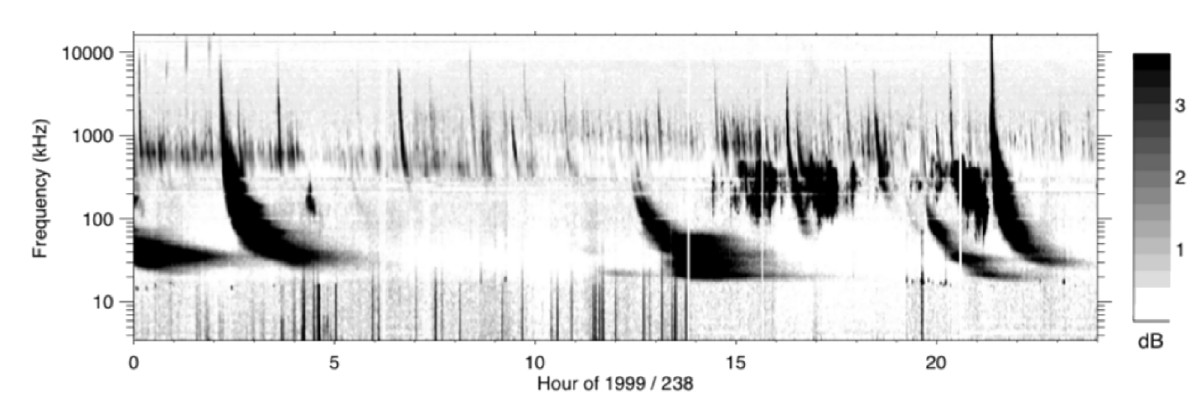
FIGURE 1 Low frequency radio dynamic spectrum recorded by Cassini/RPWS on 1999-08-26. The spectrogram is showing Solar radio bursts as well as terrestrial auroral kilometric radiation